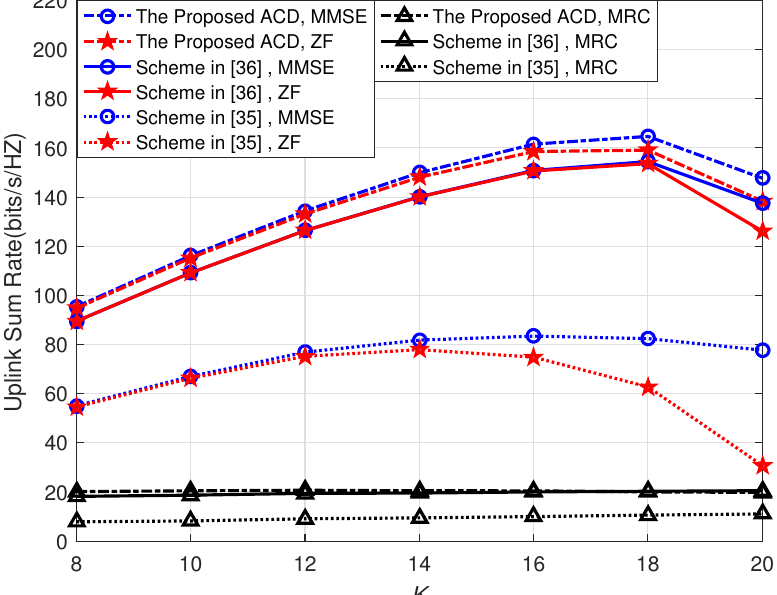
Figure 8. Uplink sum rate of the three schemes versus K , where M (cid:48) = 20.